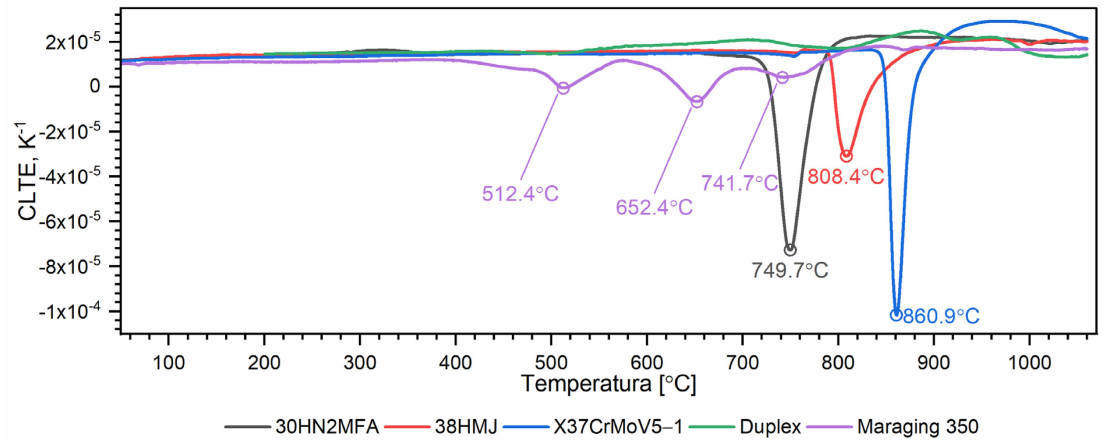
Figure 22. Comparison of CLTE as a function of temperature for X37CrMoV5 − 1, Maraging 350,